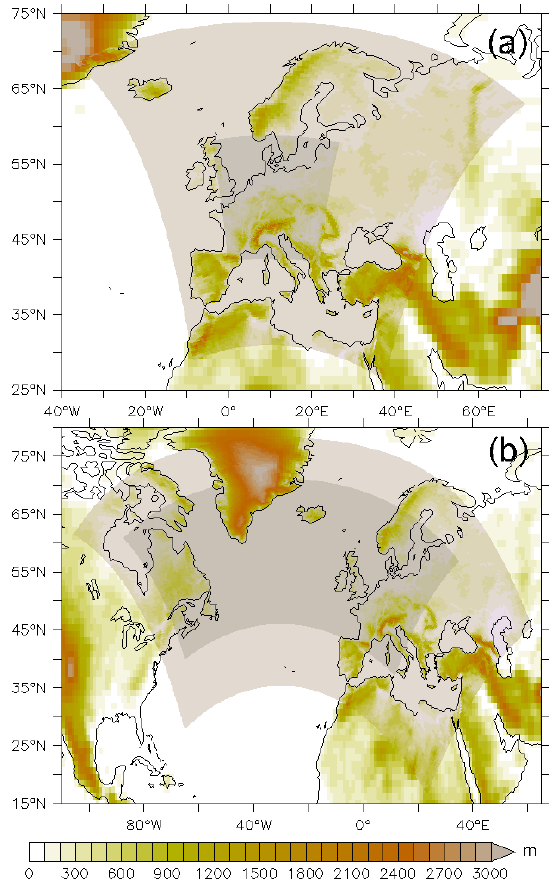
Fig. 2. Model setup, showing smaller and larger COSMO in- stances nested within EMAC. The height of the topography is shown (colours, in ma.s.l.) to illustrate the different resolutions of the instances of the MECO(2) system. Panel (a) shows the model setup used for the frontal passage over Germany (Sect. 5.1) and the convective processes during the COPS campaign (Sect. 5.2), panel (b) shows the setup for winterstorm “Kyrill” (Sect. 5.3).